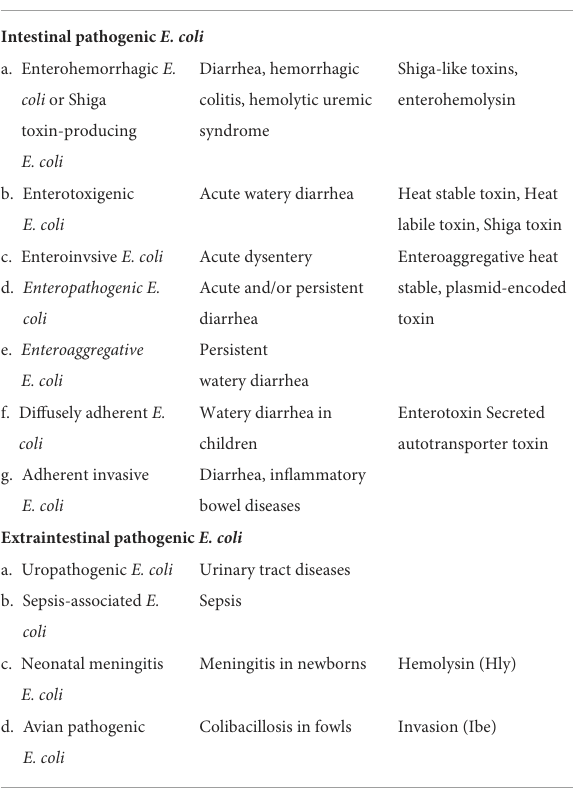
TABLE 1 Pathotypes of pathogenic E. coli , diseases, and important virulence